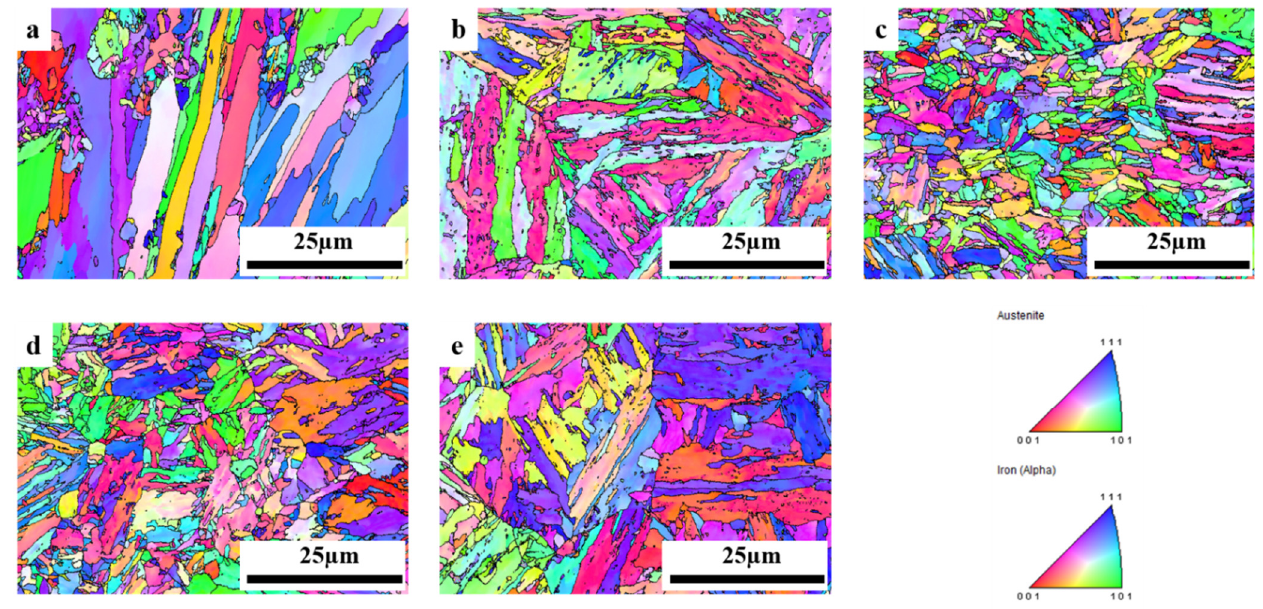
Figure 7. EBSD orientation maps obtained from the as-built and heat-treated 17-4 PH samples: ( a ) AB, ( b ) N, ( c ) S, ( d ) SA, ( e ) NSA.